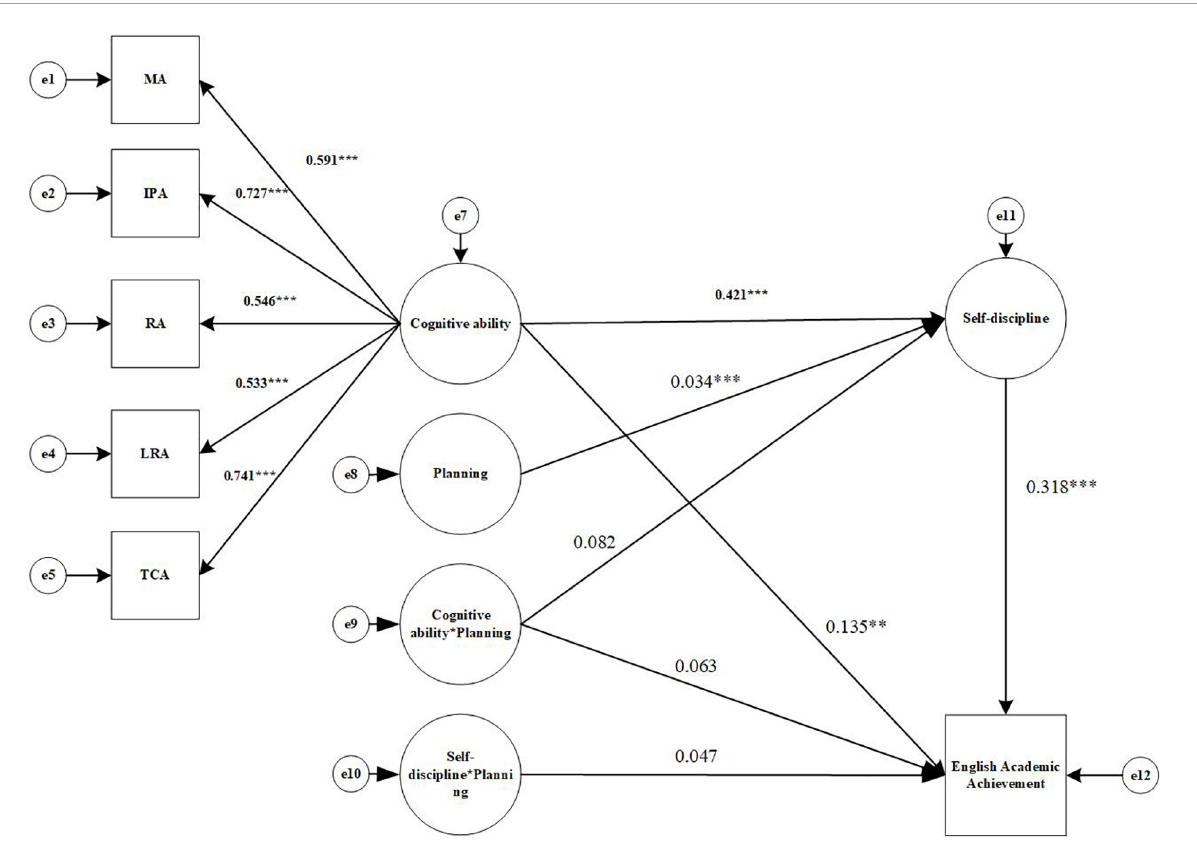
FIGURE7 Structural equation modeling results diagram (English Academic Achievement). MA, Memory ability; IPA, Information processing ability; RA, Representation ability; LRA, Logical reasoning ability; TCA, Thinking conversion ability. ∗ p < 0.05, ∗∗∗ p <